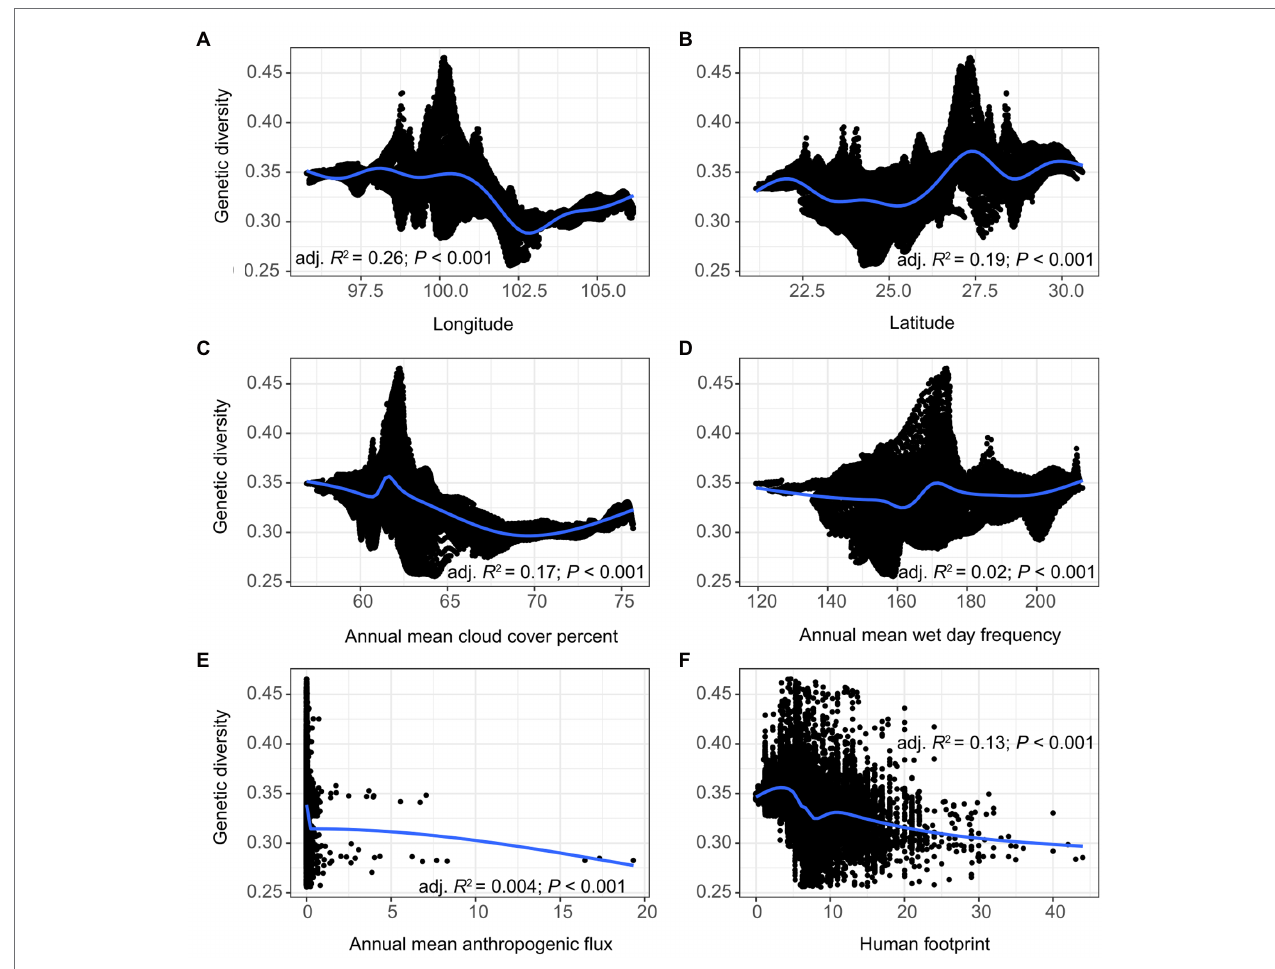
FIGURE 5 | The response of genetic diversity to (A) Longitude, (B) Latitude, (C) Annual mean cloud cover percent, (D) Annual mean wet day frequency, (E) Annual mean anthropogenic flux, and (F) Human footprint index. The black shading indicates 95% confidence